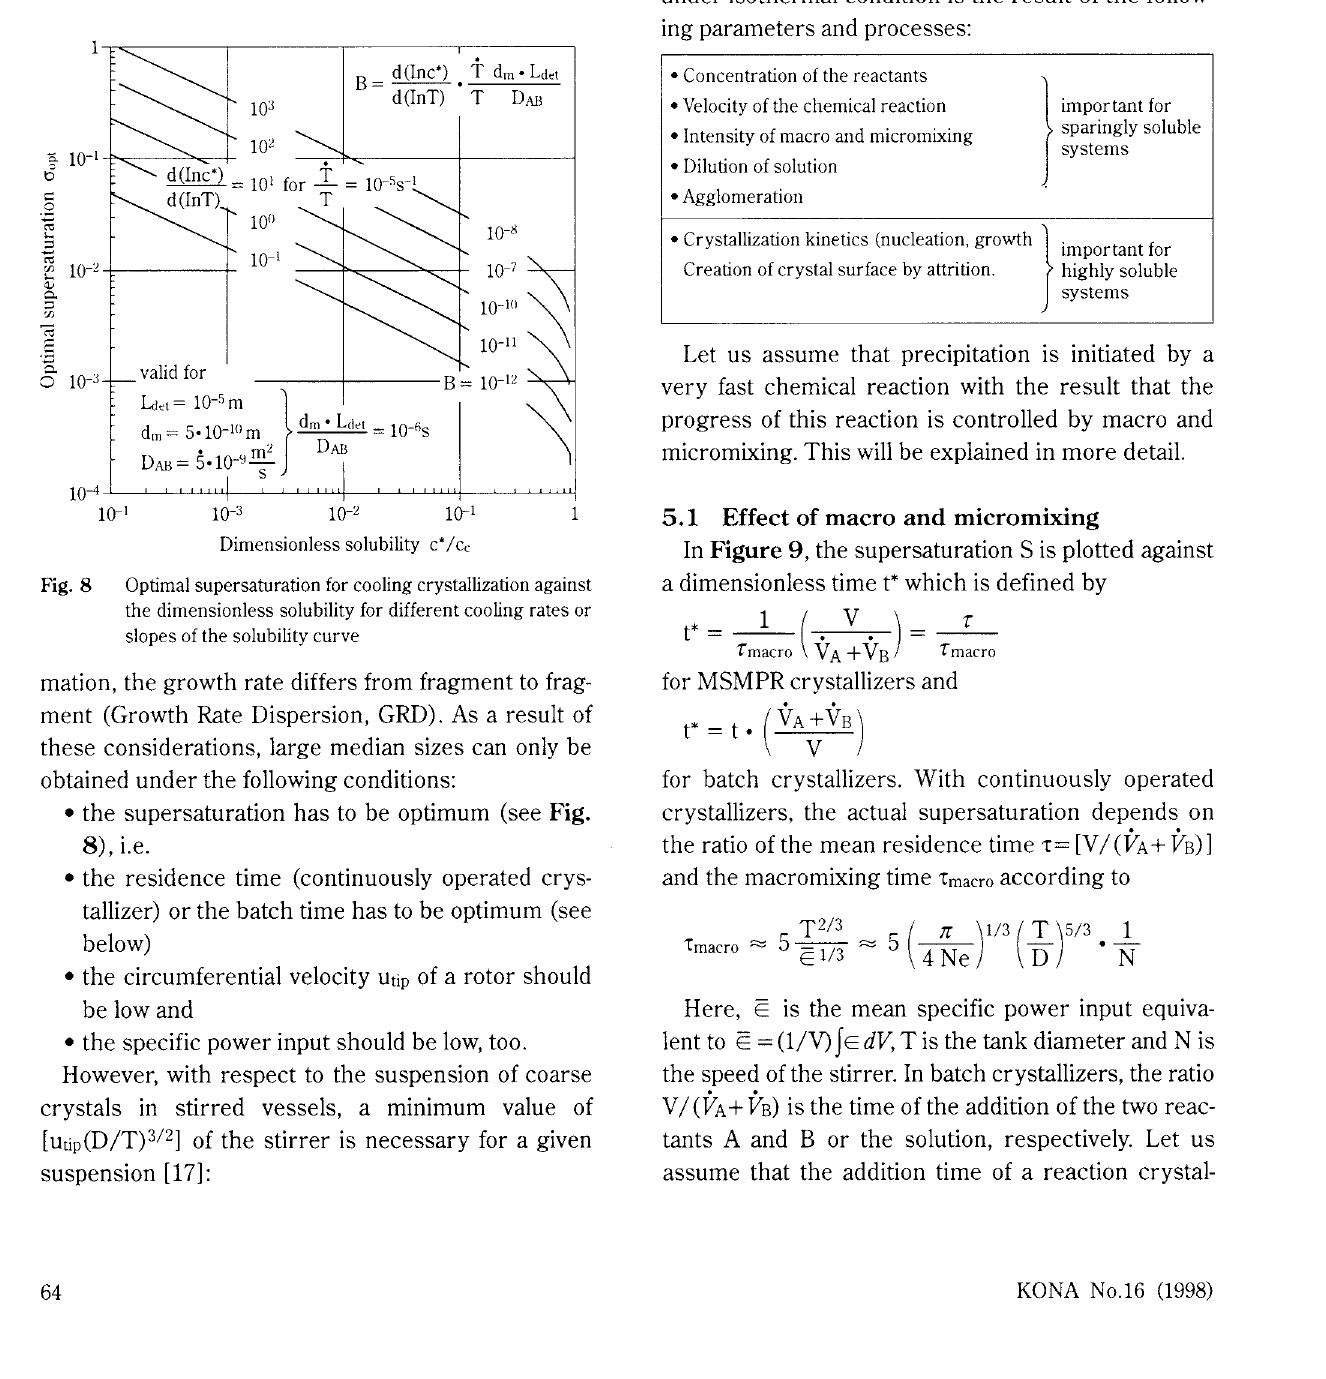
Growth rate of 356 KN03 attrition fragments against their initial size